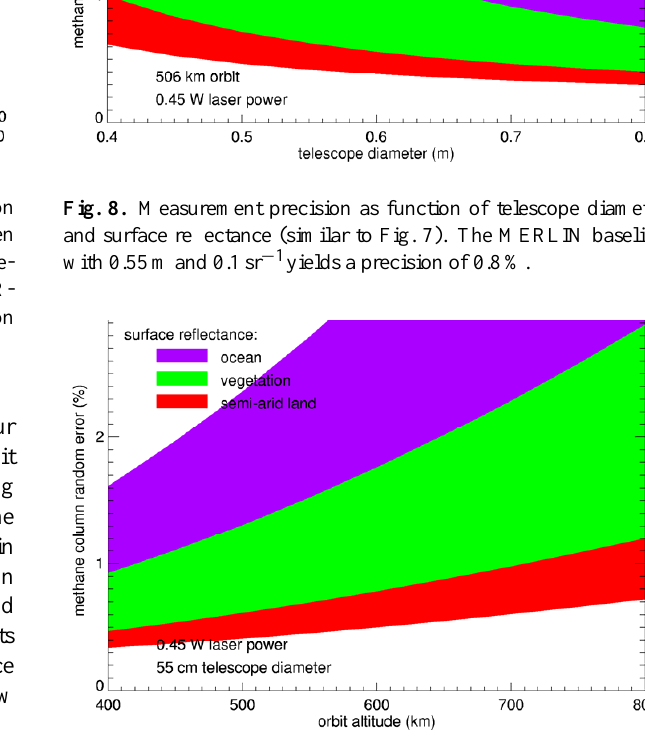
Fig. 9. Measurement precision as function of orbit height and sur- face reflectance (as Fig. 7). The MERLIN baseline of Table 2 with 506km and 0.1sr − 1 yields a precision of